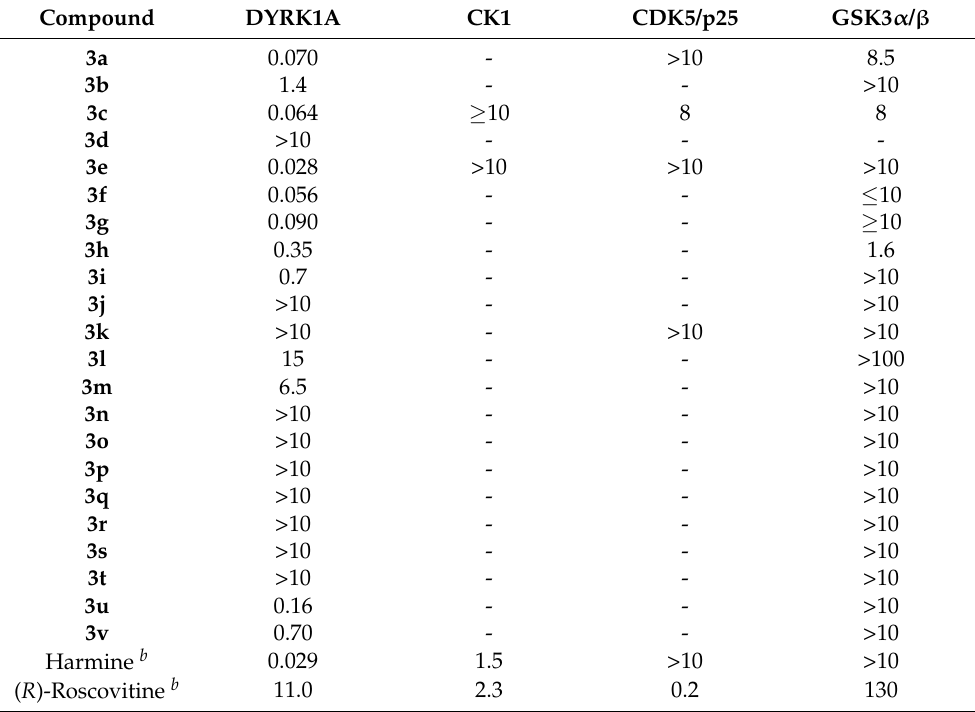
a Compounds were tested at various concentrations on each kinase as described in Experimental Section. IC values, calculated from the dose-response curves, are reported in µ M. -, inactive at the highest